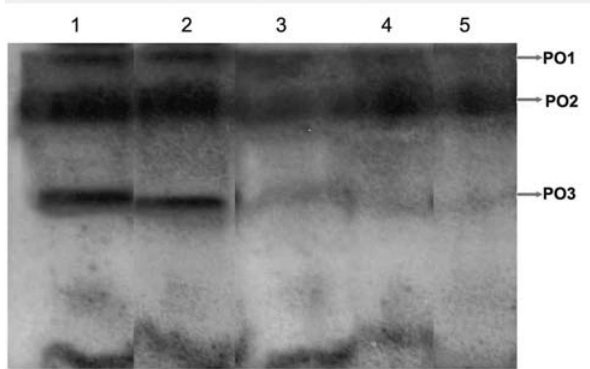
Fig. 2. Native PAGE pro fi le of peroxidase (PO) induced in response to challenge-inoculation of Pseudoperonospora cubensis in cucumber.